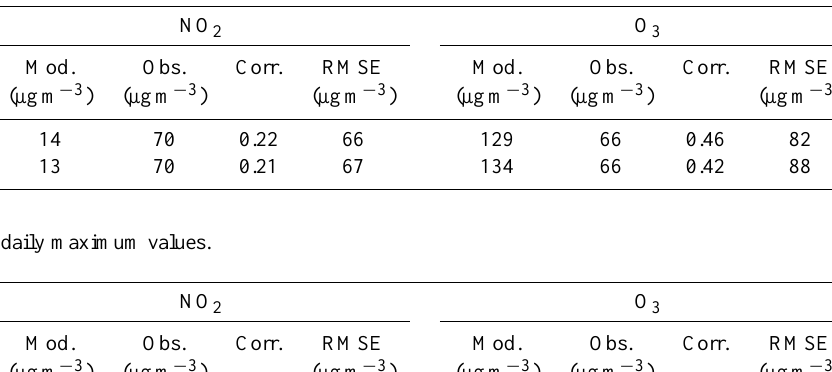
Table 1. Statistical comparisons between the near-surface concentrations of NO 2 and O 3 simulated with and without aerosols and measured at Moscow by an air quality station. Mod. and Obs. are the period-averaged modeled and observed concentration. Corr. and RMSE are the temporal correlation and the root mean square error.